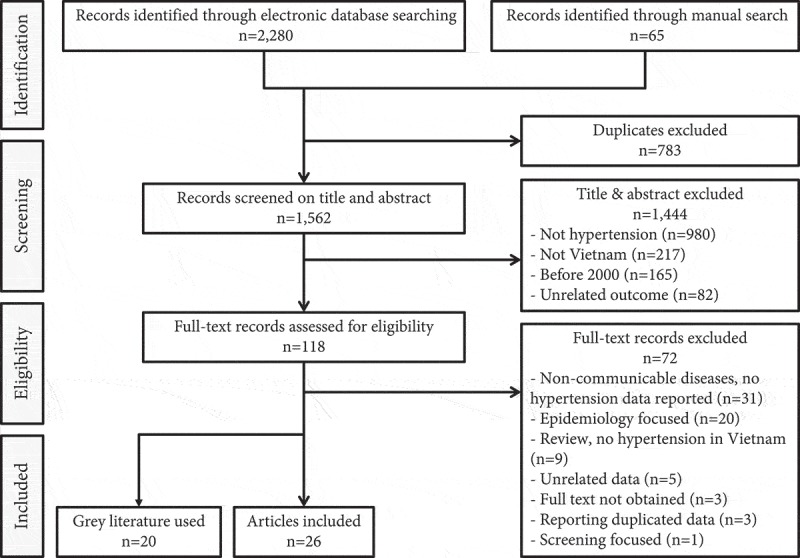
Flow diagram for study selection process.